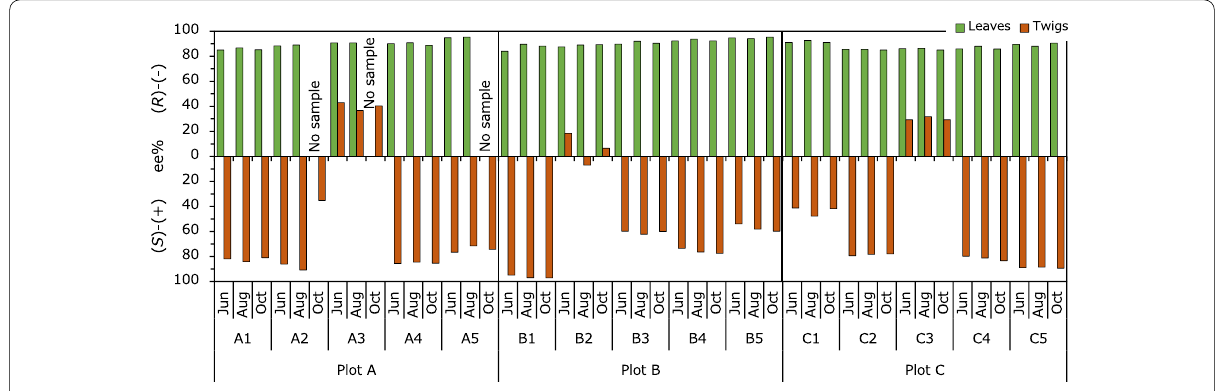
Fig. 5 Enantiomeric excesses (ee) of ( R )-(